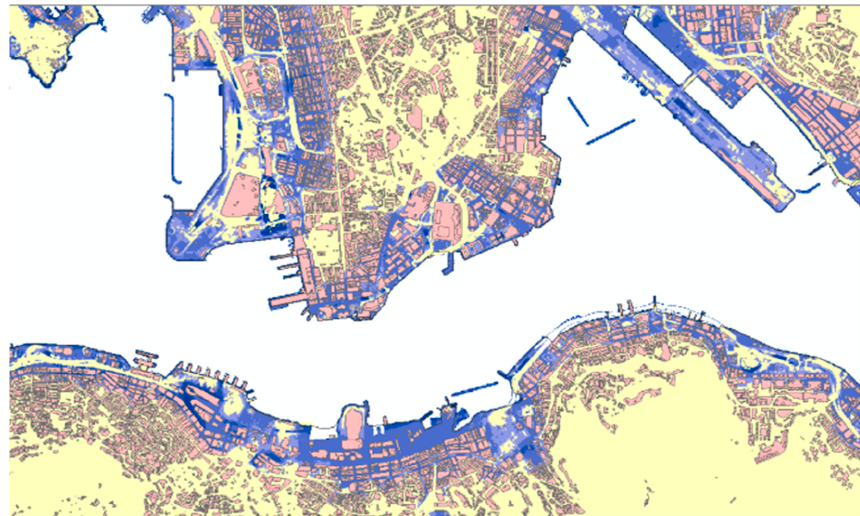
Figure 6. Overlay of building layer and exposure map of SSP 8.5.